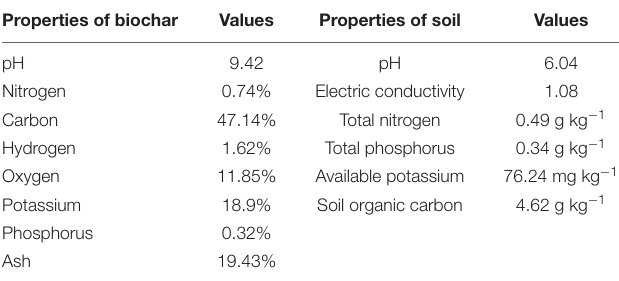
TABLE 1 | Chemical properties of biochar used and soil before the